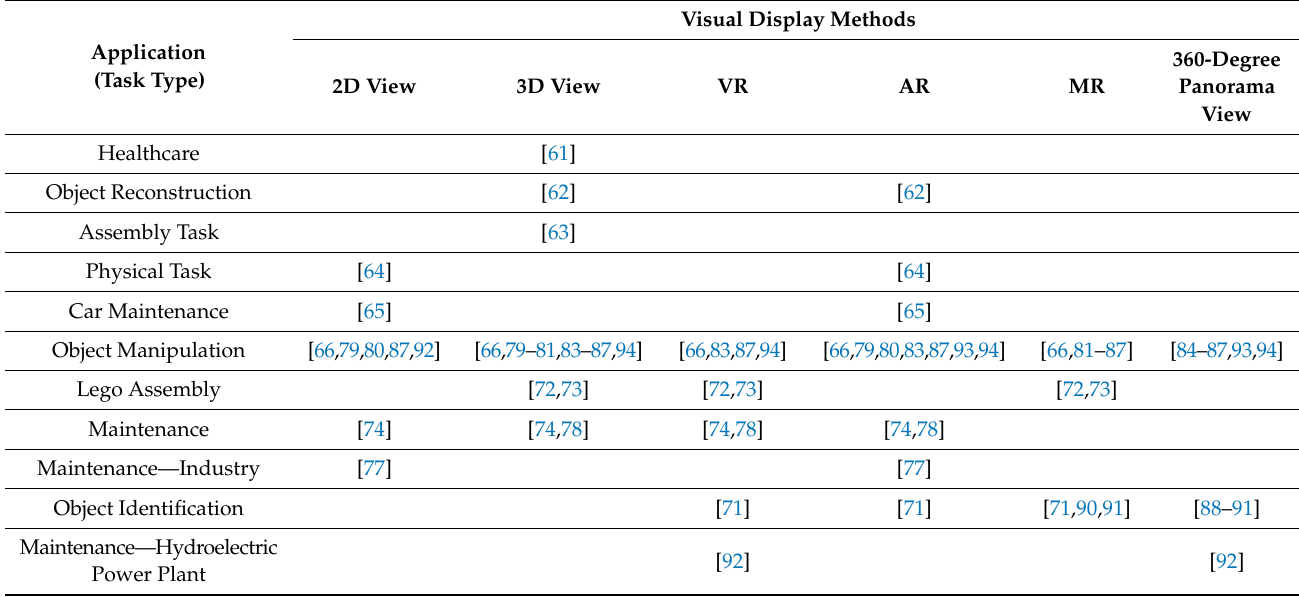
Table 2. Visual display methods used in remote